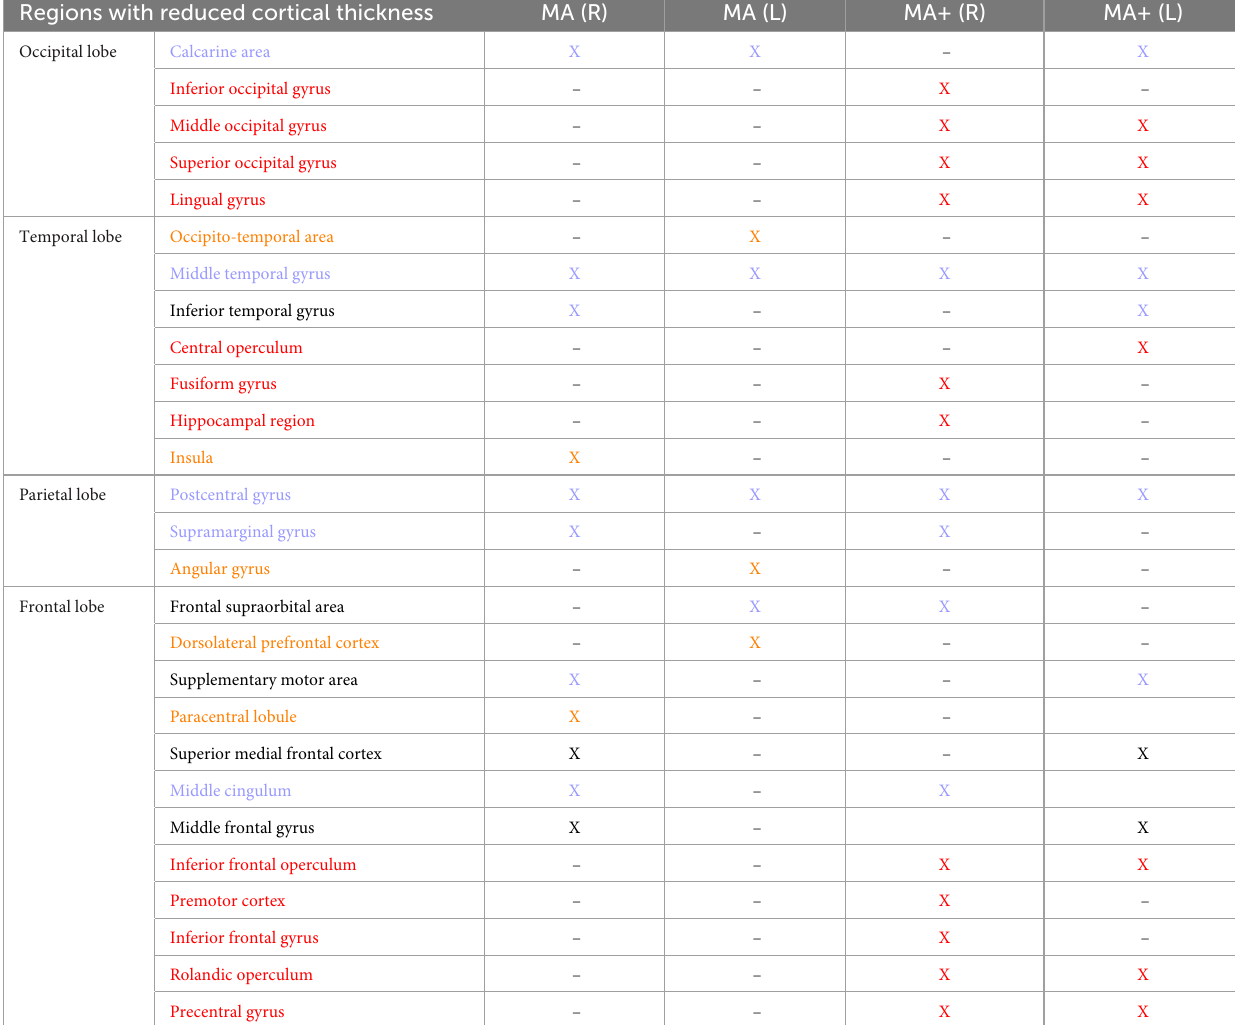
TABLE 4 Synoptic table of cortical areas with reduced gray matter in migraine with pure visual auras (MA) and migraine with complex visual auras (MA+) in comparisons with HC. Regions with reduced cortical